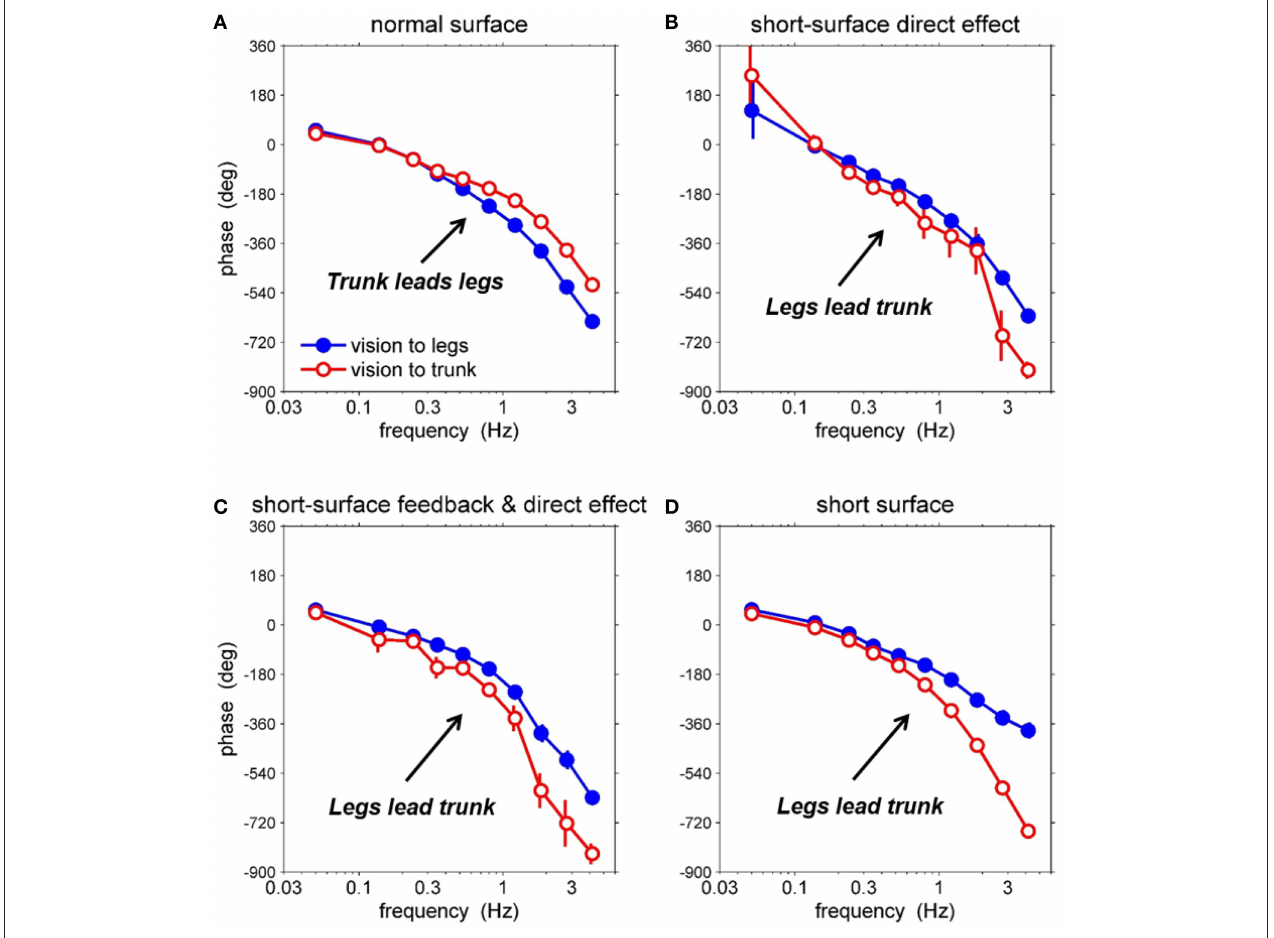
FIGURE 6 | Effects of short support surface relative to direct effect, feedback, and plant FRFs. (A) closed-loop FRF of leg/trunk relative to vision on normal supporting surface, (B) adding direct effect of short support surface, (C) adding feedback and direct effect of short support surface, (D) adding plant, feedback, and direct effect of short support surface (i.e., the closed-loop FRF from vision perturbation to body segment angles on short support